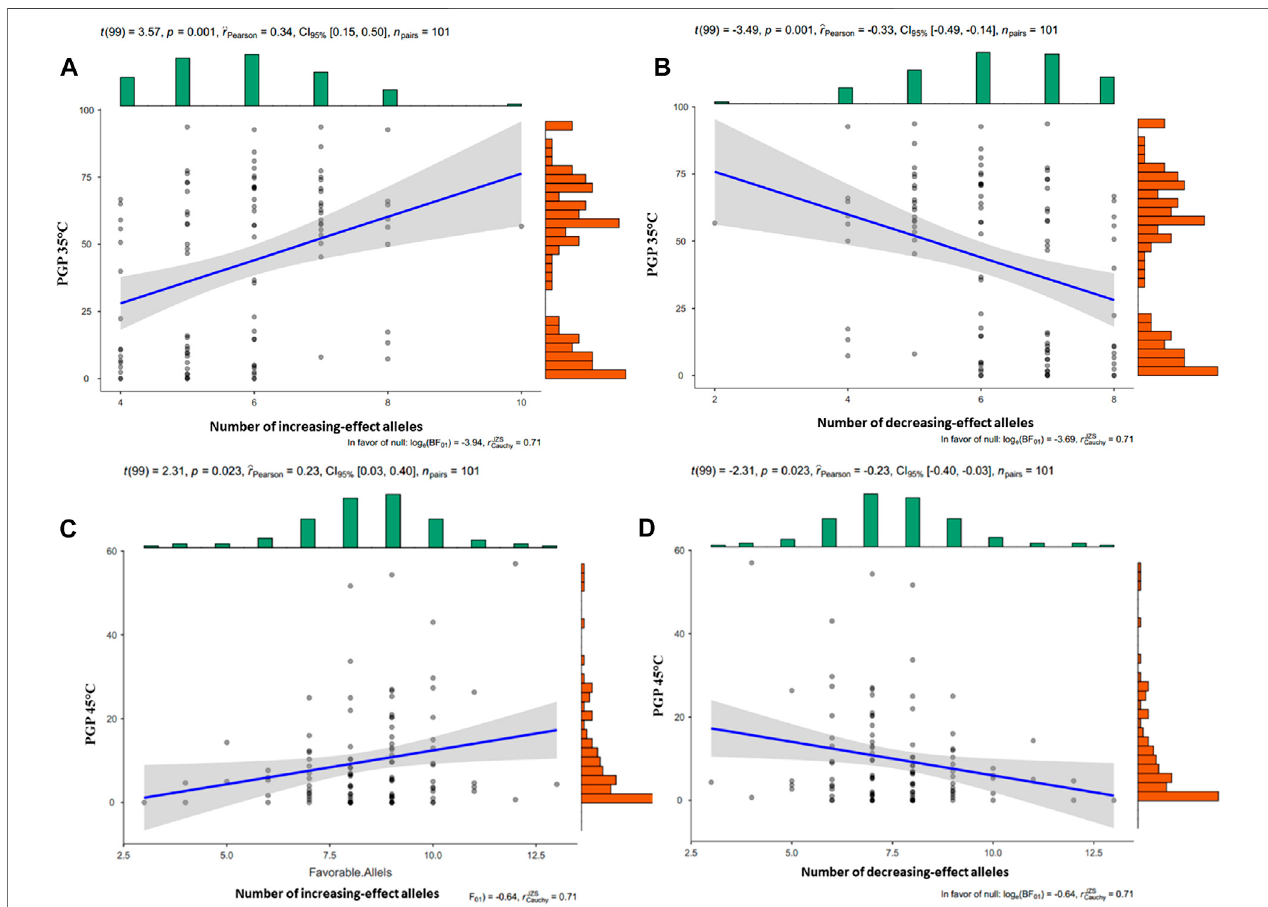
FIGURE 3 | Cummulative effect of the number of favorable (A) and unfavorable (B) alleles on PGP 35 ° C, and of the favorable (C) and unfavorable (D) alleles on PGP45 ° C. The dots represent the mean values. The scatter plot shows PGP on the y-axis and number of alles on the x-axis.